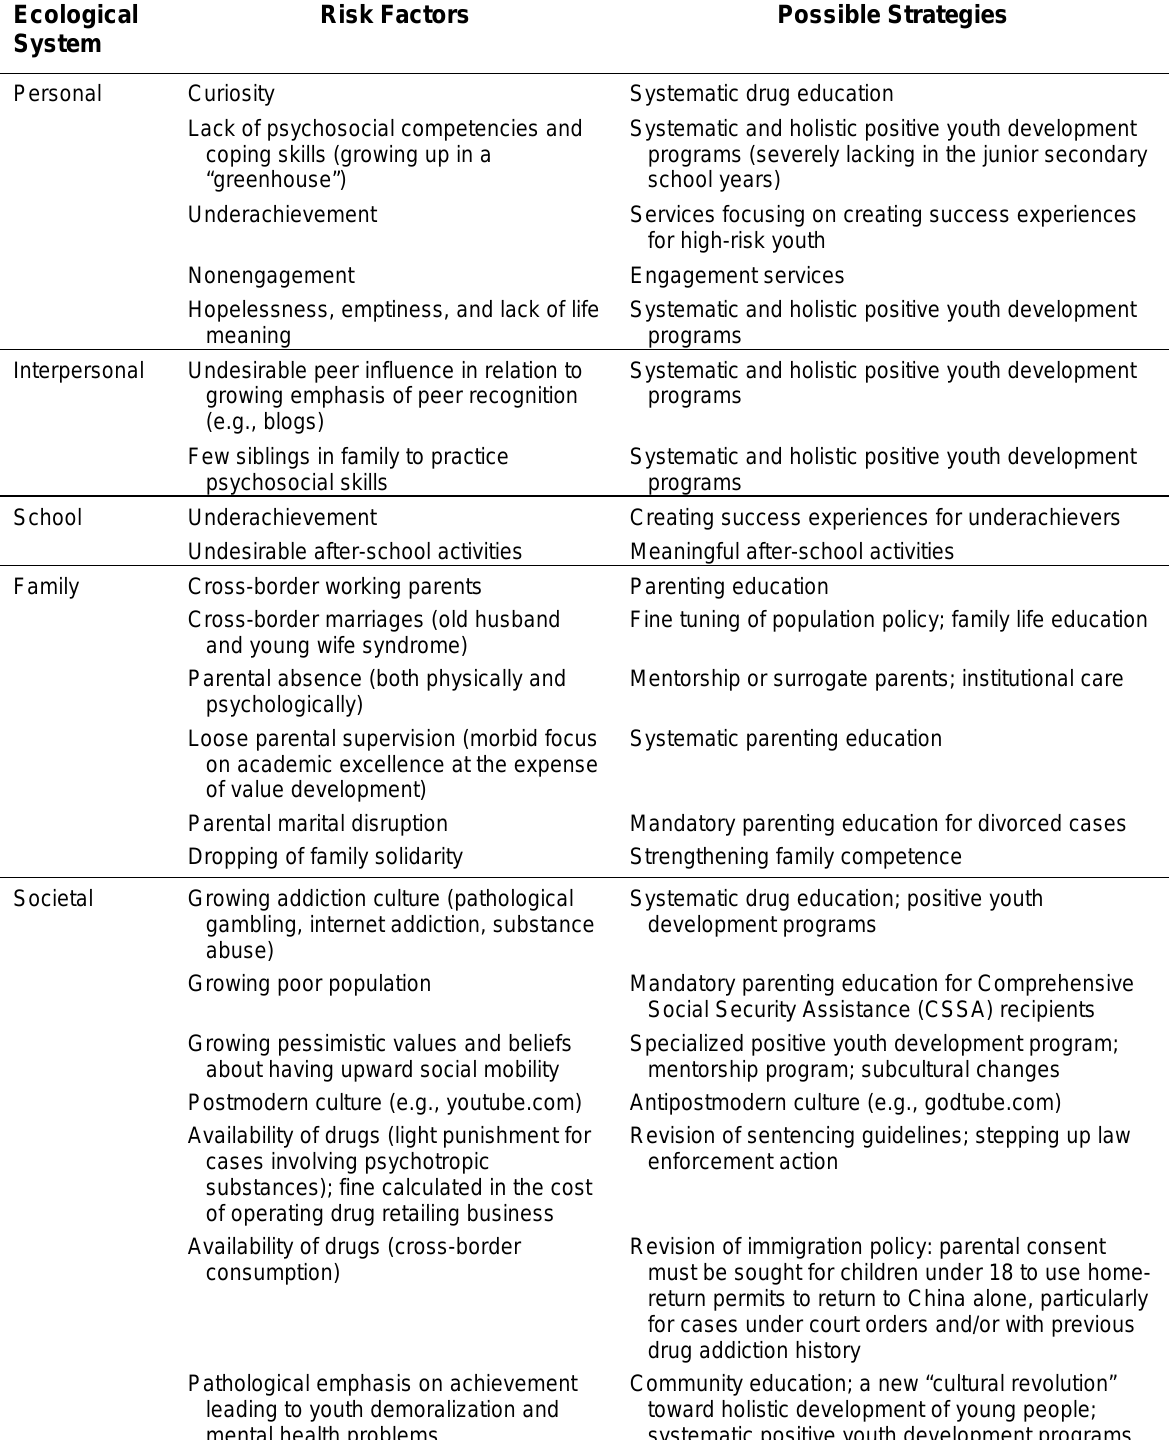
Strategies with Reference to the Personal, Interpersonal, School, Family, and Societal Systems